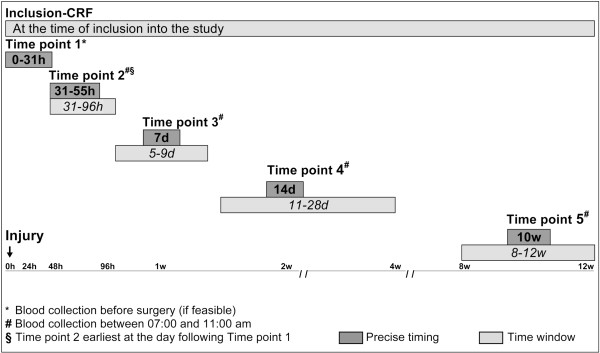
Longitudinal trial design. Legend: Assessment points and time frames. The starting point of the time line is the time of injury not the time of surgery. In the case of difficulties in scheduling the visits 2 to 5 may be conducted within the indicated time windows (italic). The circadian rhythmics are respected.